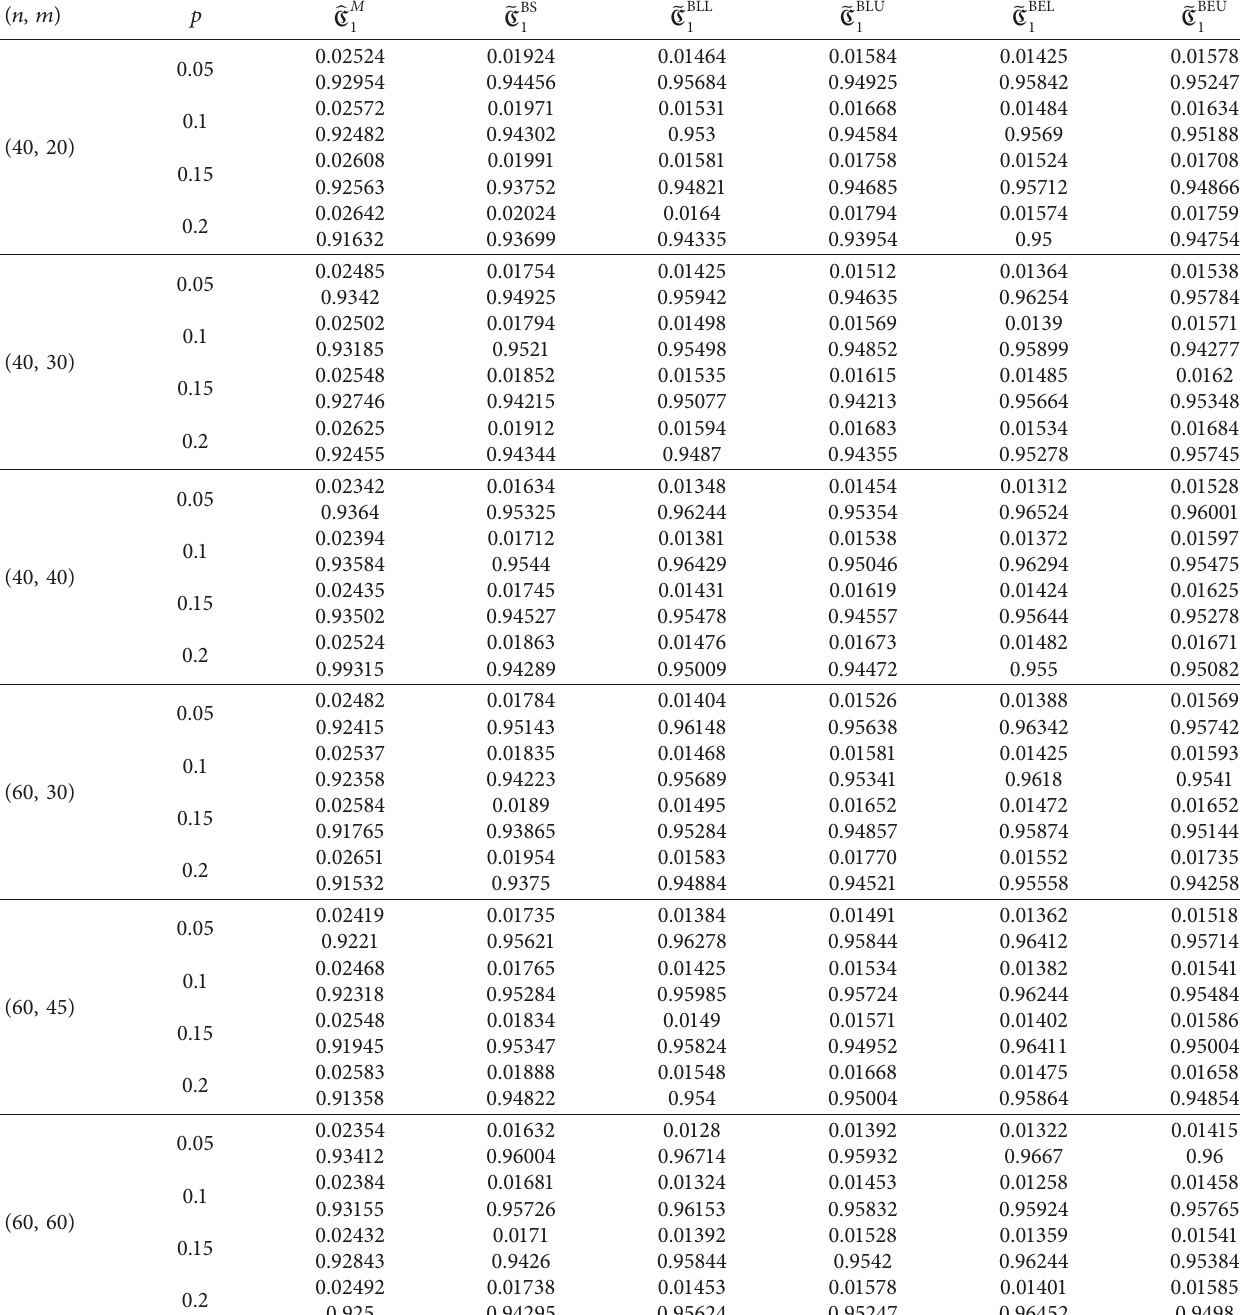
Table 11: Confidence interval of cumulative incidence function for first component C for n